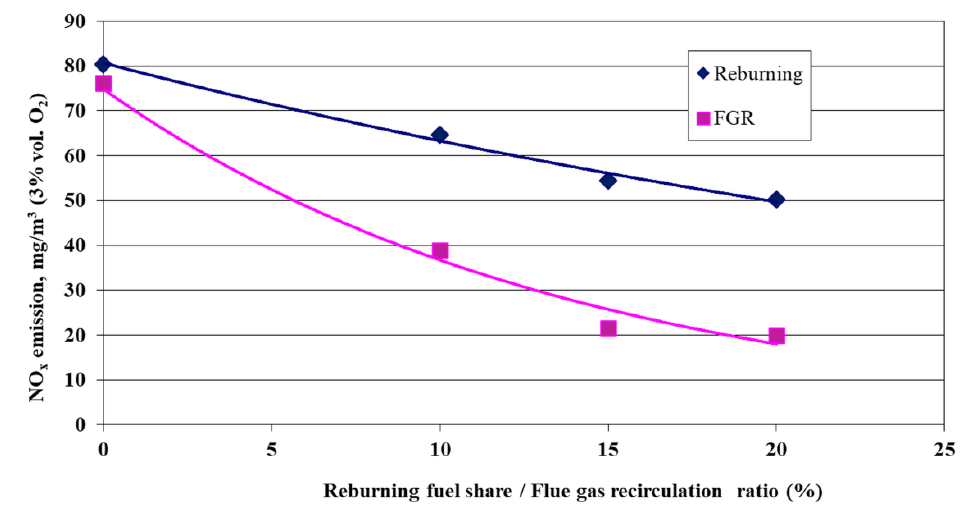
Figure 3. Flue-gas recirculation and reburning methods: denitrification efficiency comparison at total fuel input Q = 1.5 m 3 /h and air excess coefficient m = 1.1.